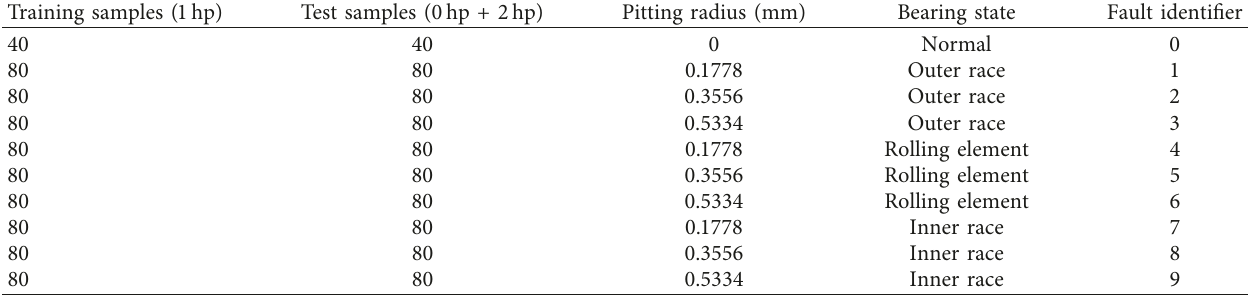
Table 4: Experimental data under variable load conditions.